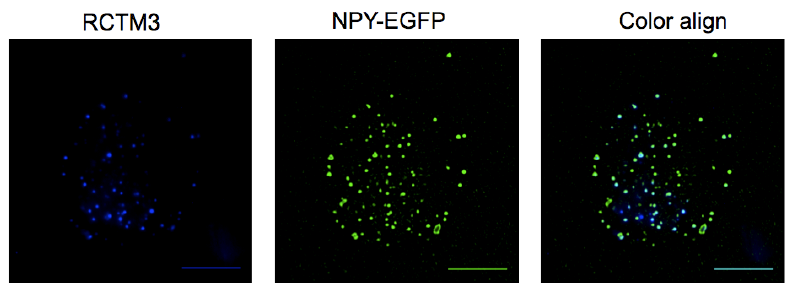
Figure 2. Intracellular location of RTCM-3 in a PC12 cell. ( A ). TIRFM images obtained from eight PC12 cells incubated for 10 min with RTCM-3 (10 µM); and ( B ). transfected with human pro-NPY tagged with EGFP (NPY-EGFP) Panel ( C ) shows a merged image of the other two images where coincident pixels are yellow (Bar, 10